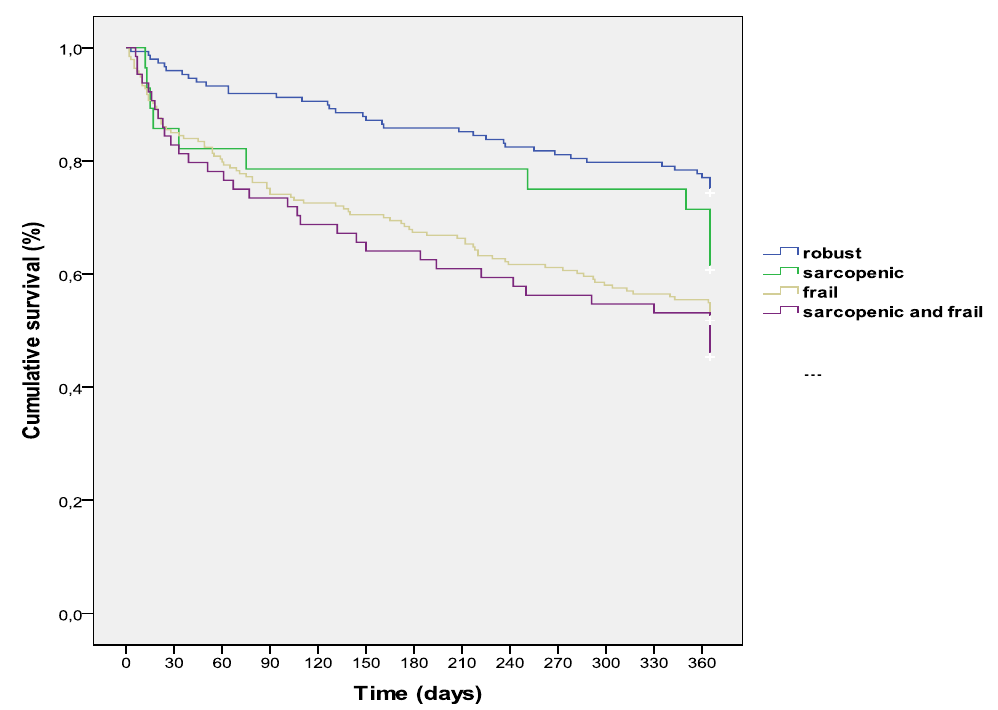
Figure 2. Kaplan–Meier 12-month survival curves of a multicenter cohort of polypathological patients according to the presence of sarcopenia, frailty, or both.